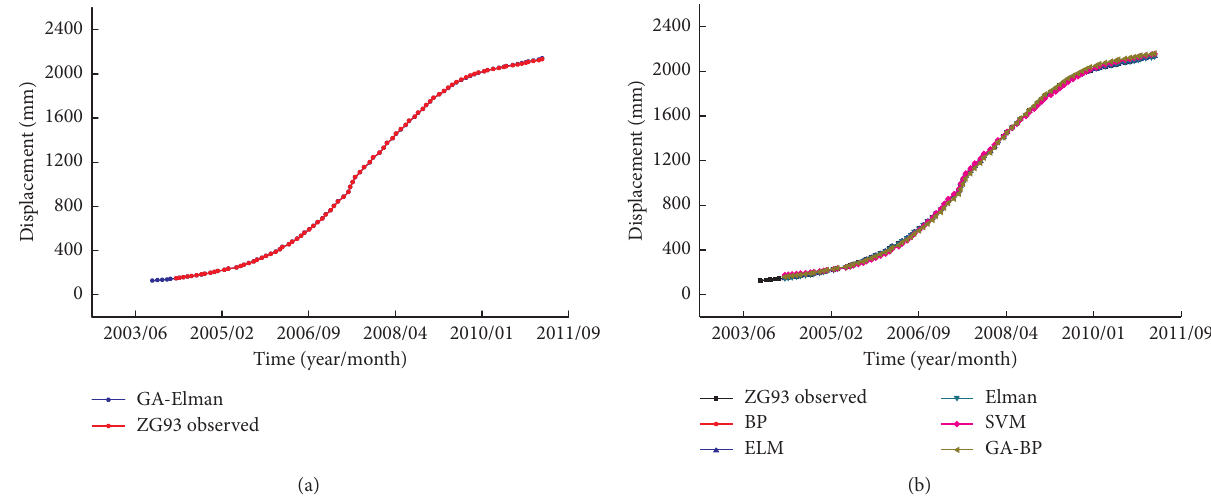
Figure 7: Comparisons between the observed displacements and fitting curves through models for point ZG93 in the Baishuihe landslide: (a) GA-Elman model; (b) other